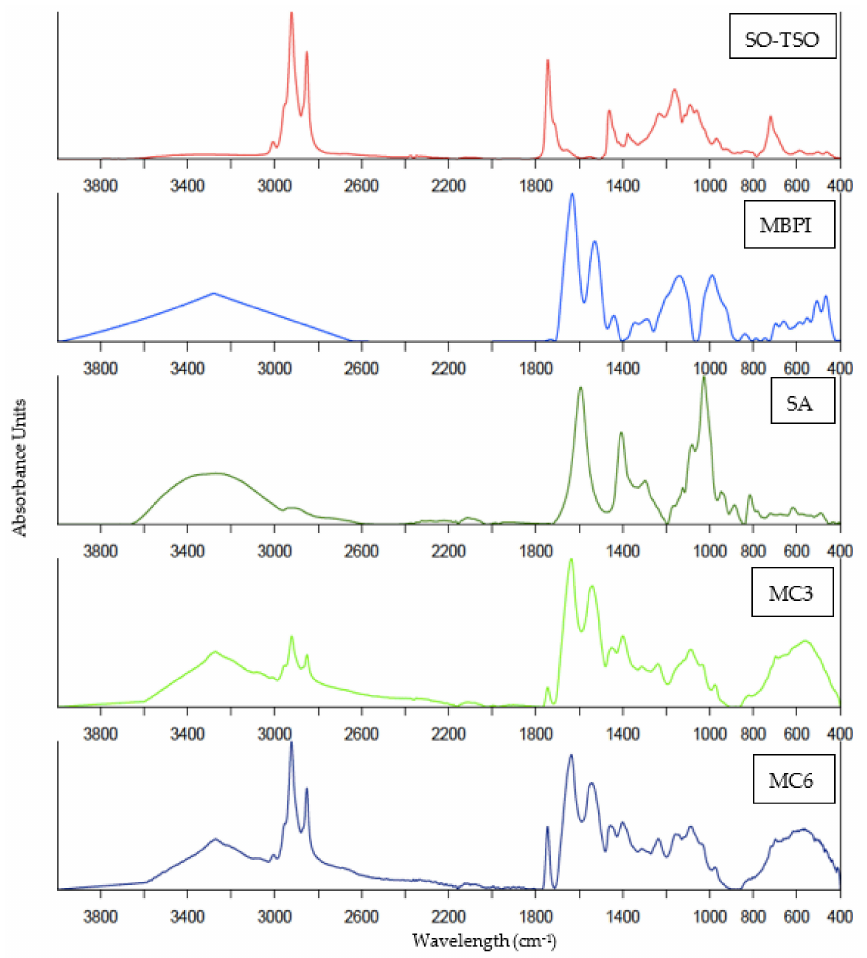
Figure 2. FTIR spectra of SO-TSO, MBPI, SA, MC3, and MC6 (for Captions, see Figure